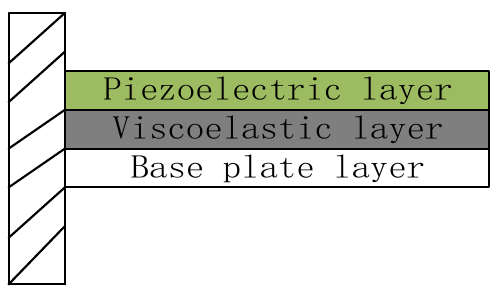
Figure 2. Active restrained damping sandwich panels.